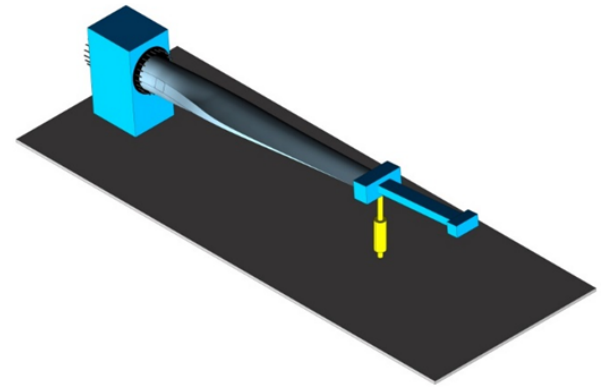
Figure 6. Cantilever structure for root segment test.